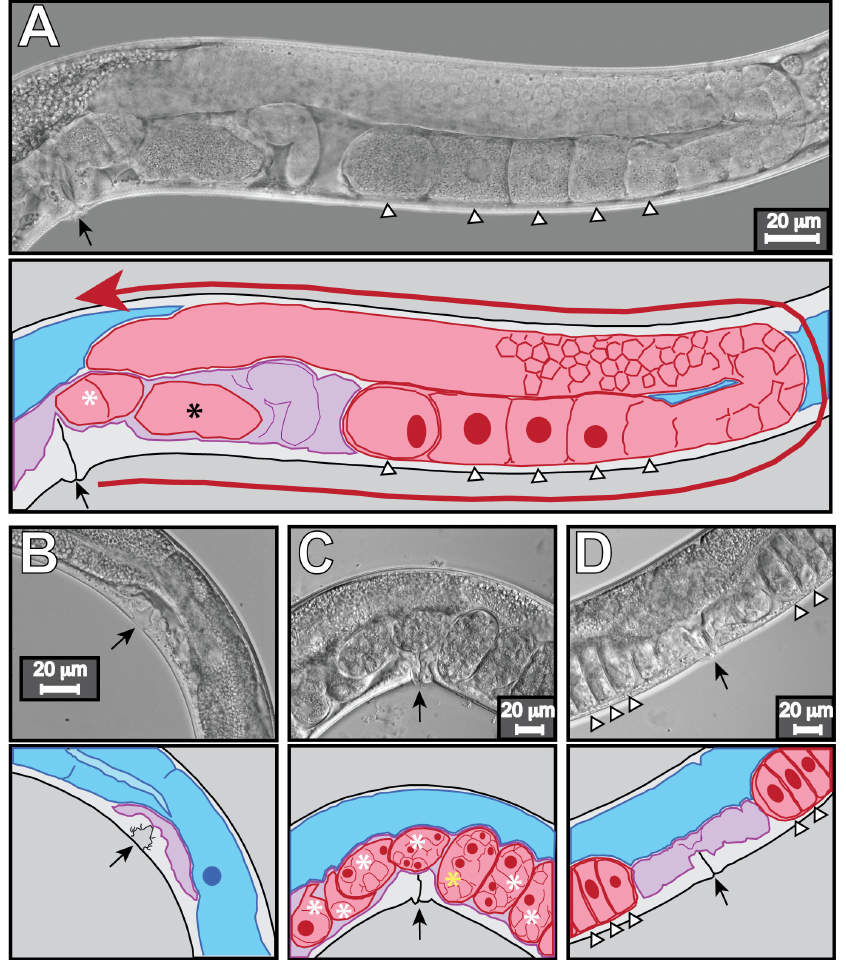
Figure 1. Morphological markers of life-stage and fertility in C. elegans . Detailed descriptions of P. pacificus vulva and gonad development are available [38,39,42]. Panels include a DIC micrograph on top and a cartoon of the micrograph below. For body orientation, anterior is to the left and dorsal to the top. Black arrows mark the position of the vulva, the egg- laying organ. Asterisks in the cartoons denote developing embryos in utero and are not shown in the micrograph for clarity. White triangles denote the position of oocytes. Tissues are denoted by color: gut, blue; uterus and spermatheca, purple; germ line (including the germ cells, oocytes, and developing embryos), red. Ovals and circles depict easily seen nuclei within tissues. (A) Young adult hermaphrodite. The entire posterior gonad arm is shown. The red arrow outlines the path of gonad arm extension starting proximal to the vulva and terminating with the arrowhead at the distal tip. As an adult, this animal has made sperm, oocytes, and contains embryos, has two fully reflexed and inflated gonadal arms, and a fully everted vulva with a slit like morphology. The black asterisk denotes an egg in the spermatheca that has just been fertilized but has not developed an eggshell yet. In contrast, L4 larvae never contain embryos as they only begin to produce gametes late in the L4-stage. The L4 gonad arms are smaller and not as inflated, and early in L4 have only reached the dorsal side of the animal, but do not reach the center above the vulva until late in L4. (B) Wild type early L4-larva hermaphrodite detail of uterus and vulva. The vulva has a characteristic “Christmas tree” like shape, it is not everted. The uterus is empty and un-inflated. Gametes have not been produced, the gonad arms are skinny and contain relatively few germ cells making the gonad arms difficult to capture in the same focal plane as the vulva. (C) Wild type adult hermaphrodite detail of uterus and vulva. The uterus is full of multicellular embryos. The gold asterisk denotes an embryo with a clearly visible eggshell. The eggshell is present as an oval around the ball of cells. The embryo and shell are separated by a slim cleared liquid-filled space. (D) Adult fog- 2 female detail of uterus and vulva. fog-2 females do not produce sperm and contain no embryos. Hence the uterus and spermatheca remain unexpanded. Unfertilized oocytes stack up in the gonad arms and become compressed, giving a “piano key” phenotype. Eventually pressure may push an oocyte into the uterus and the oocyte will be laid, but without an eggshell. Laid oocytes have a “mushy” appearance and remain single celled until decomposition. The edge of a laid embryo has a refractory appearance due to the